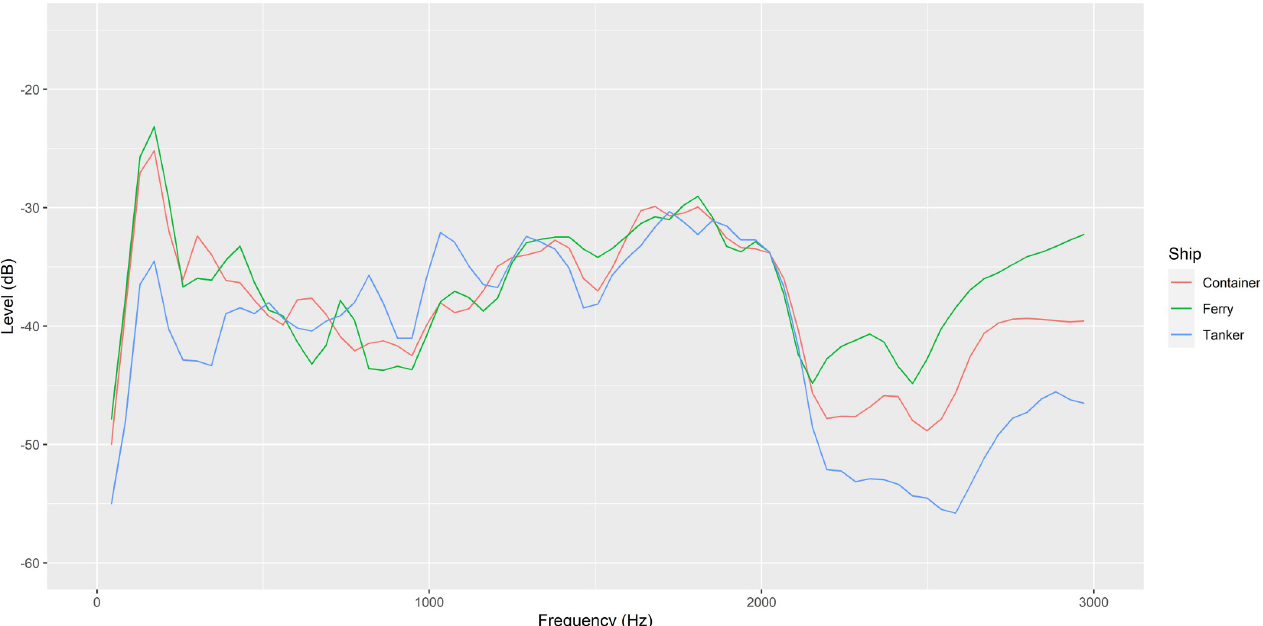
Fig 4. Spectrograph (Hann window, size 1024) showing the average sound profile (amplitude/level and frequency) of the in-tank noise levels of playback recordings